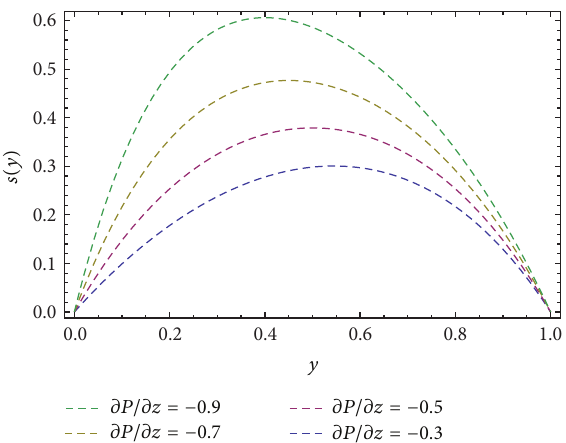
Figure 8: Velocity profile 𝑠(𝑦) for different values of 𝛼 , keeping 𝛽 = 1.0 , 𝜕𝑃/𝜕𝑥 = −0.5 , 𝜕𝑃/𝜕𝑧 = −0.5 , and 𝜙 = 45 ∘ .